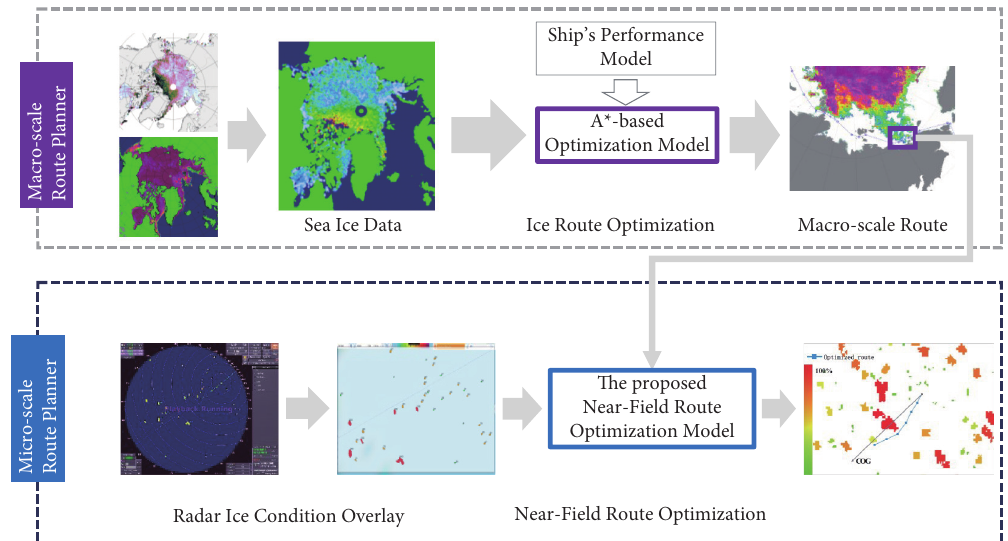
Figure 5: Framework overview for ship route optimization in polar ice